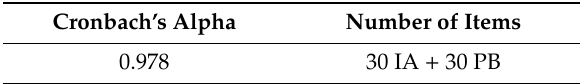
Table 4. Reliability Statistics. Cronbach’s Alpha Number of Items 0.978